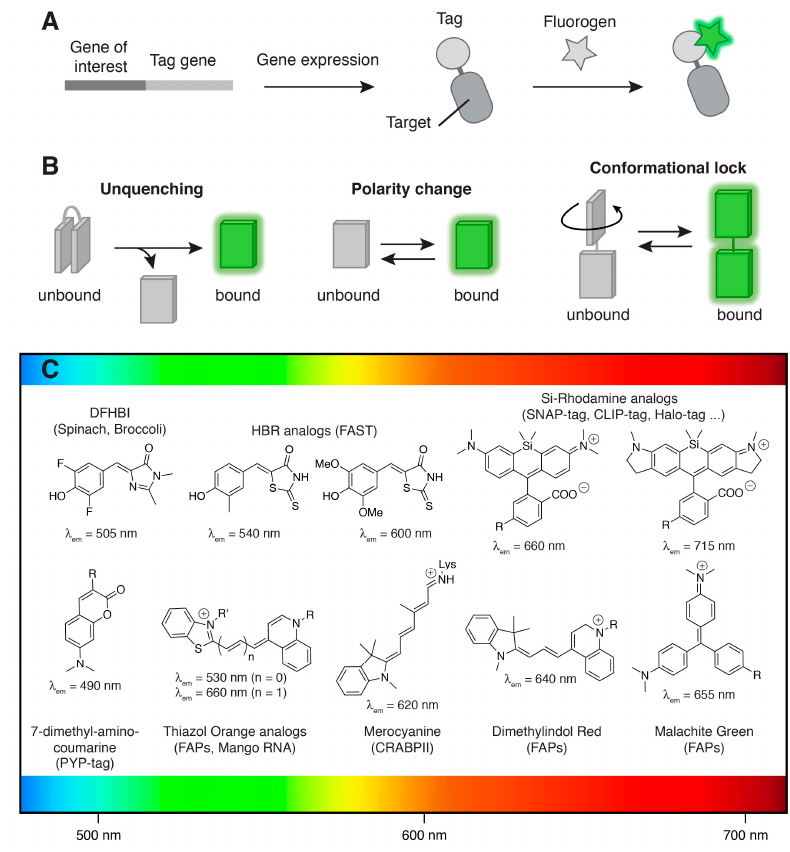
Figure 1. Fluorogenic labeling. ( A ) Selective fluorogenic labeling through genetic fusion to a tag (protein or RNA) able to bind a synthetic fluorogenic chromophore (so-called fluorogen) and activate its fluorescence; ( B ) Binding-induced fluorogenic response can result from various processes such as (i) unquenching of intramolecularly quenched fluorophores, (ii) fluorescence increase upon polarity change or (iii) conformational locking of molecular rotors or conjugated push-pull systems; ( C ) Main synthetic fluorogenic chromophores utilized for the development of fluorogenic labeling methods. The maximal emission wavelengths of the fluorogens bound to their cognate tag are given. Abbreviations: DFHBI = 3,5-difluoro-4-hydroxybenzylidene imidazolidinone; HBR = 4-hydroxybenzylidene rhodanine. The design of ( B ) was inspired from Reference